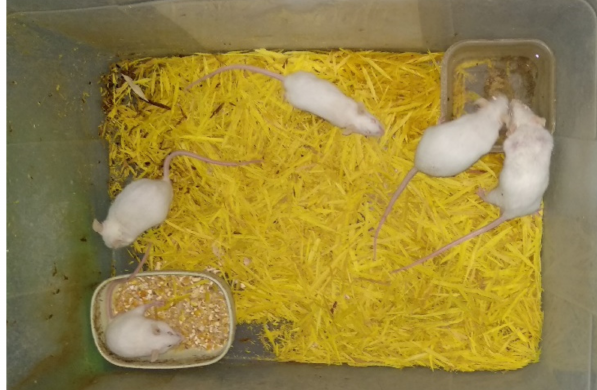
Figure 2. A group of Swiss albino mice after 28 days of color